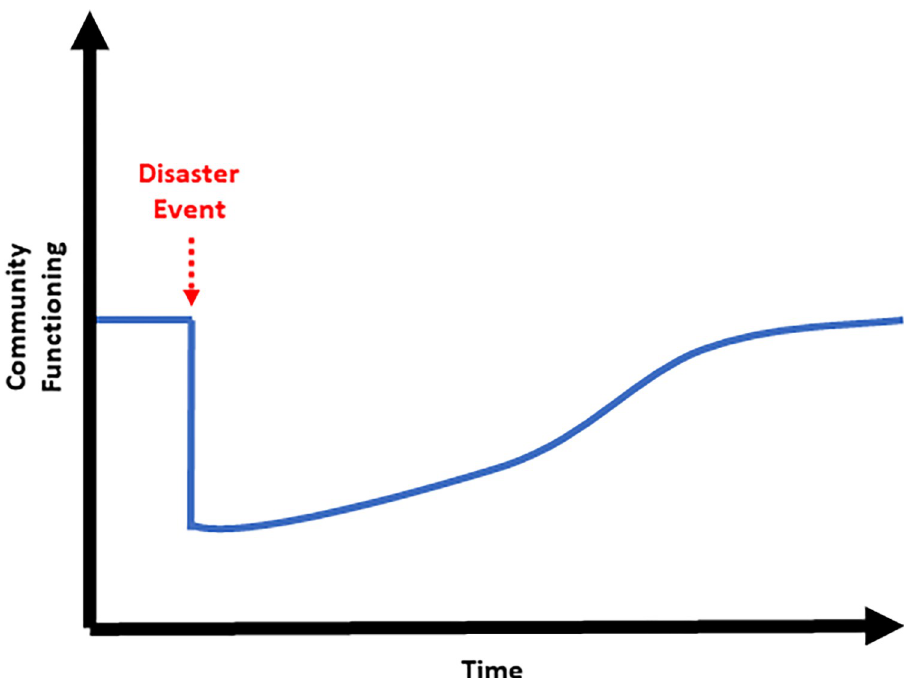
Fig 2. Reference mode of community functioning over time, before and after a disaster event (e.g., climate